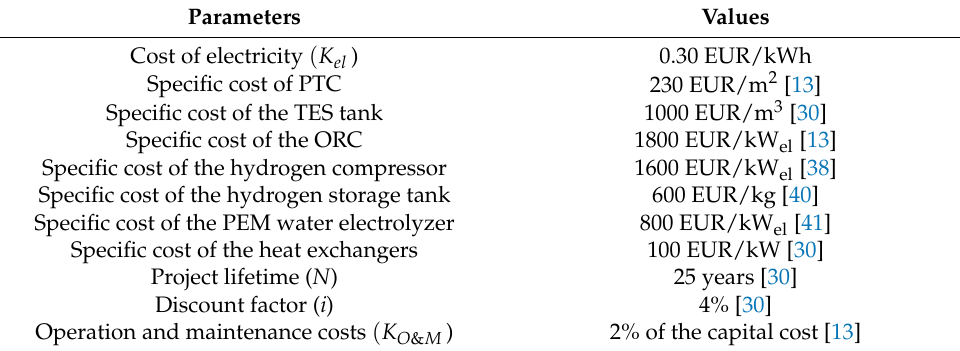
Table 3. Parameters of financial